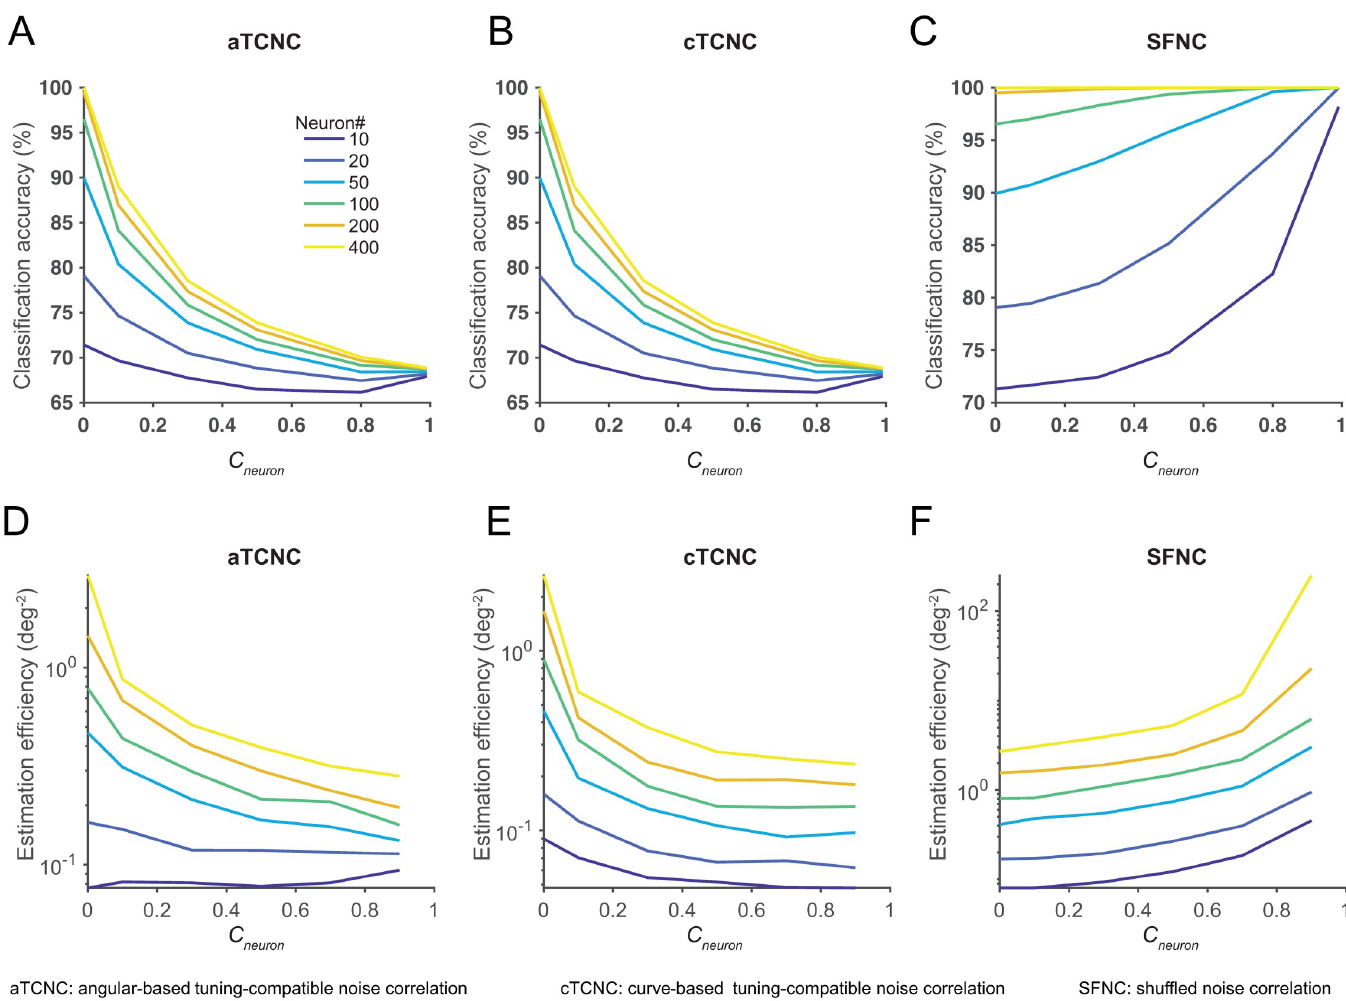
Fig 4. TCNCs impair population codes in a neuronal population. The multivariate classification accuracy (panels A-C) and maximum likelihood estimation efficiency (panels D-F) are depicted as a function of the magnitude of the aTCNC (panels A, D), TCNC (panels B, E) and the SFNC (panels C, F). Both classification accuracy and estimation efficiency decline as the strength of aTCNC and cTCNC increases. Conversely, increasing the strength of SFNC improves decoding accuracy.